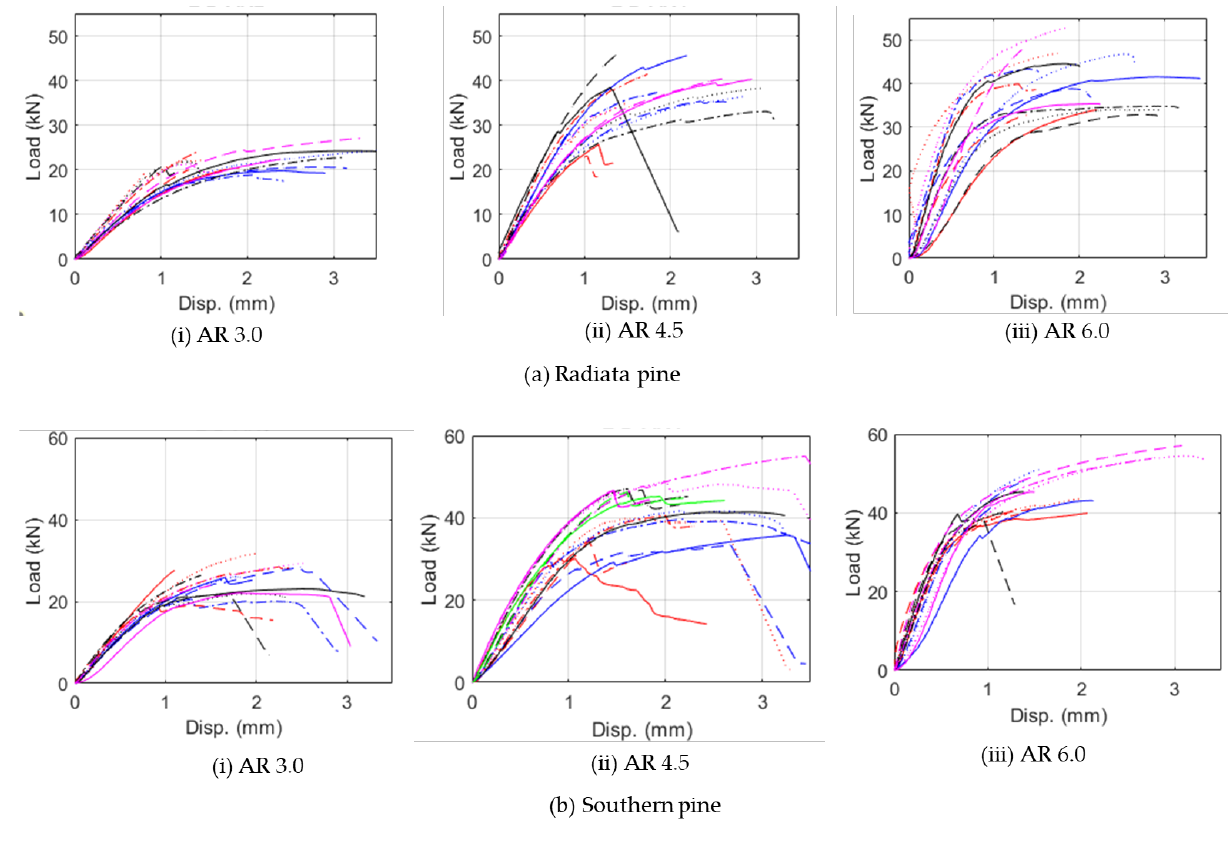
Figure 11. Load vs displacement plot of ( a ) Radiata pine and ( b ) Southern pine samples.